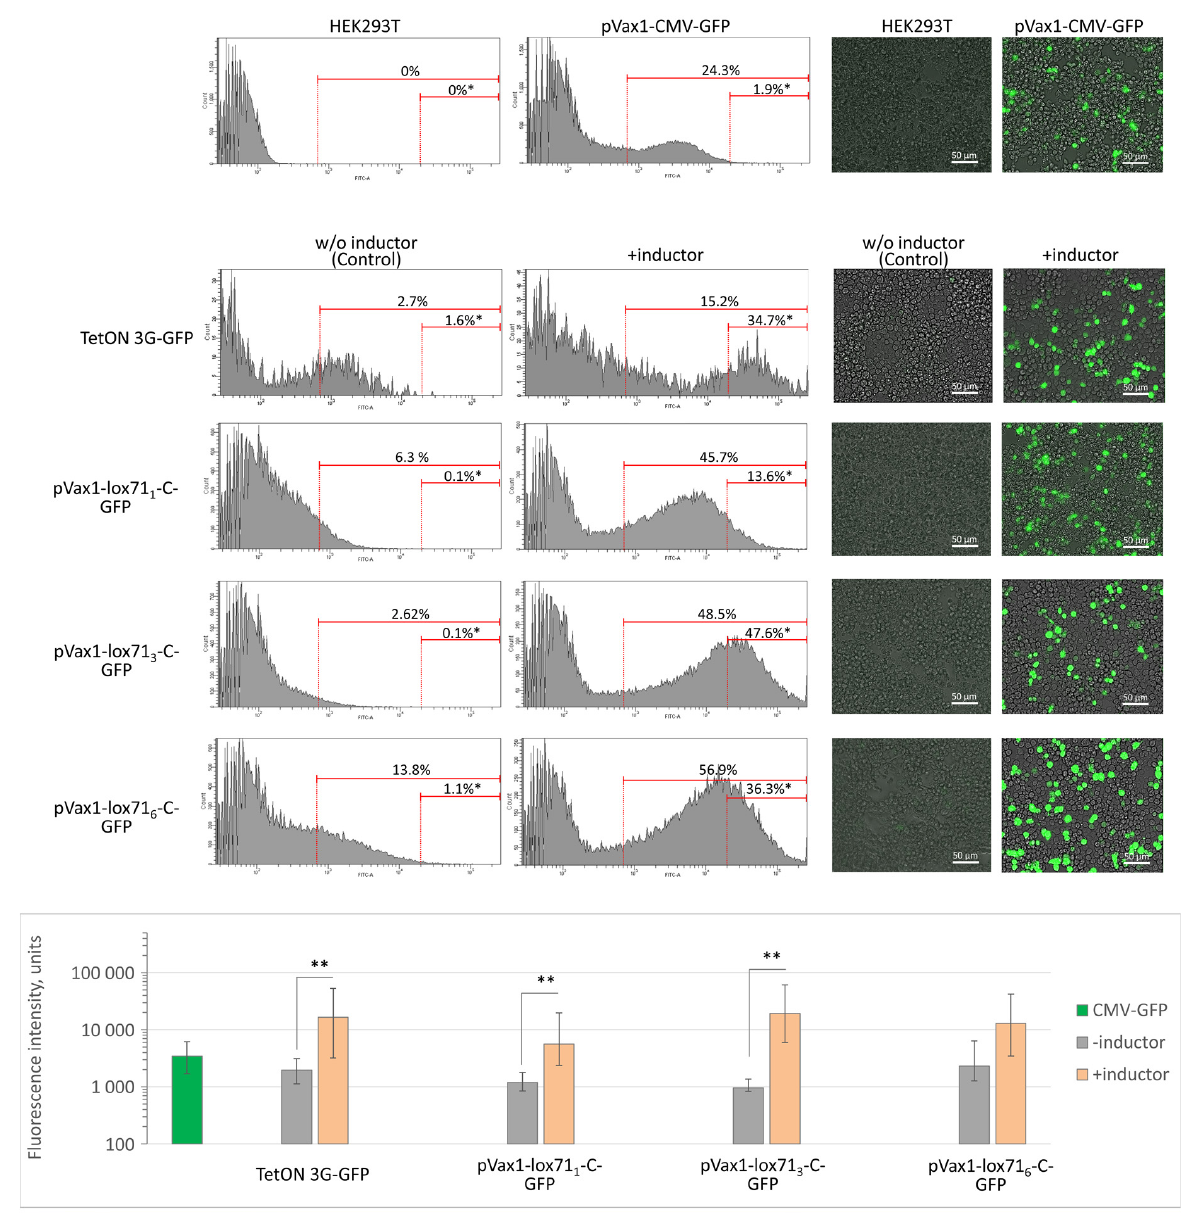
Figure 4. The effect of the number of lox71 sites on the transgene expression. Left panel—flow cytometry analysis of HEK293T cells transfected with the pVax1-lox71-C-GFP with one, three or six lox71 sites or control plasmids 48 h after the transfection. Right panel—fluorescent microscopy of transfected cells 48 h after the transfection. The number of lox71 sites is indicated within the construct name. Inductor: transfection by dCre ∆ 331 -VP4 gene for lox71 system and doxycycline for TRE3G promoter. *, The percentage of bright HEK293T cells among all GFP-positive cells; **, p < 0.05 compared to GFP fluorescence intensity of cells transfected with the appropriate plasmids without induction, n ≥ 30,000. Inductors: doxycycline for TetON 3G-GFP and dCre ∆ 331 -VP4 for lox71 1/3/6 - containing plasmids. In the diagram, data are presented as the median (25%;